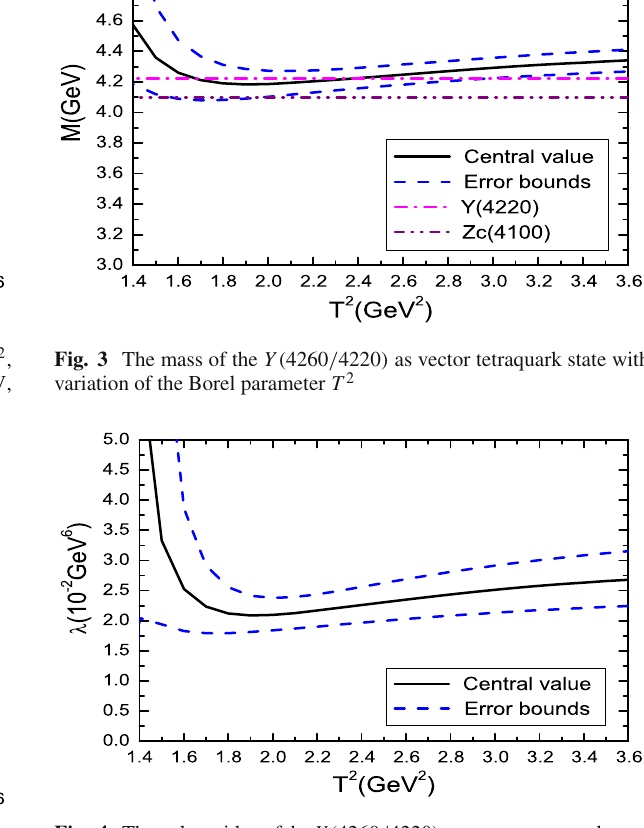
Fig. 4 Thepoleresidueofthe Y ( 4260 / 4220 ) asvectortetraquarkstate with variation of the Borel parameter T